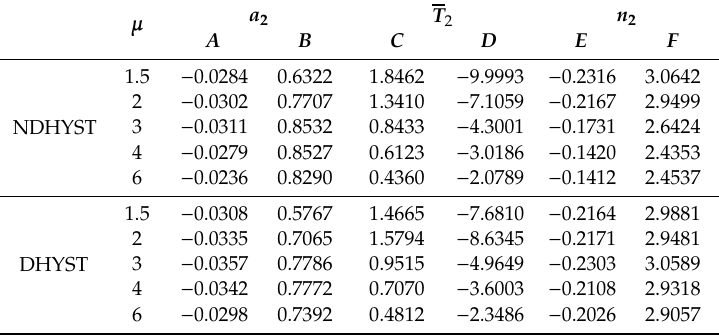
Table A3. Numerical values of the constants involved in the closed-form approximation of the mean minus one standard deviation spectrum of the hysteretic energy reduction factor R Ha . (NDHYST: non-degrading hysteretic behavior; DHHYST: degrading hysteretic